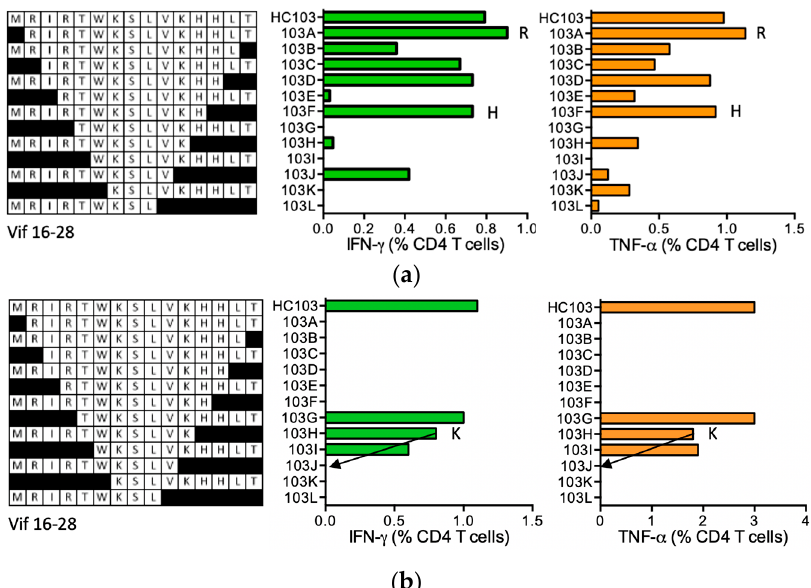
Figure 12. HC103 / VIDs 406 and 409—definition of CD4 + T-cell epitopes in HIV-1 protein Vif. HC103 STCL of vaccine recipients 406 ( a ) and 409 ( b ) were incubated with shorter peptides (left) and the production of IFN- γ (green) and TNF- α (orange) by CD4 + T cells was quantified in a polychromatic flow cytometry. Arrows and amino acid K indicate the stimulatory peptide termini.